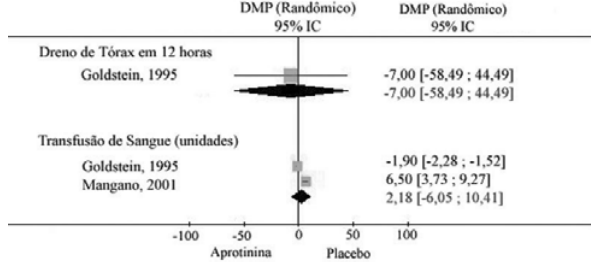
Fig. 7 - Metanálise das variáveis contínuas dos estudos que administraram alta dose de aprotinina. DMP = diferença de média ponderada; IC = intervalo de